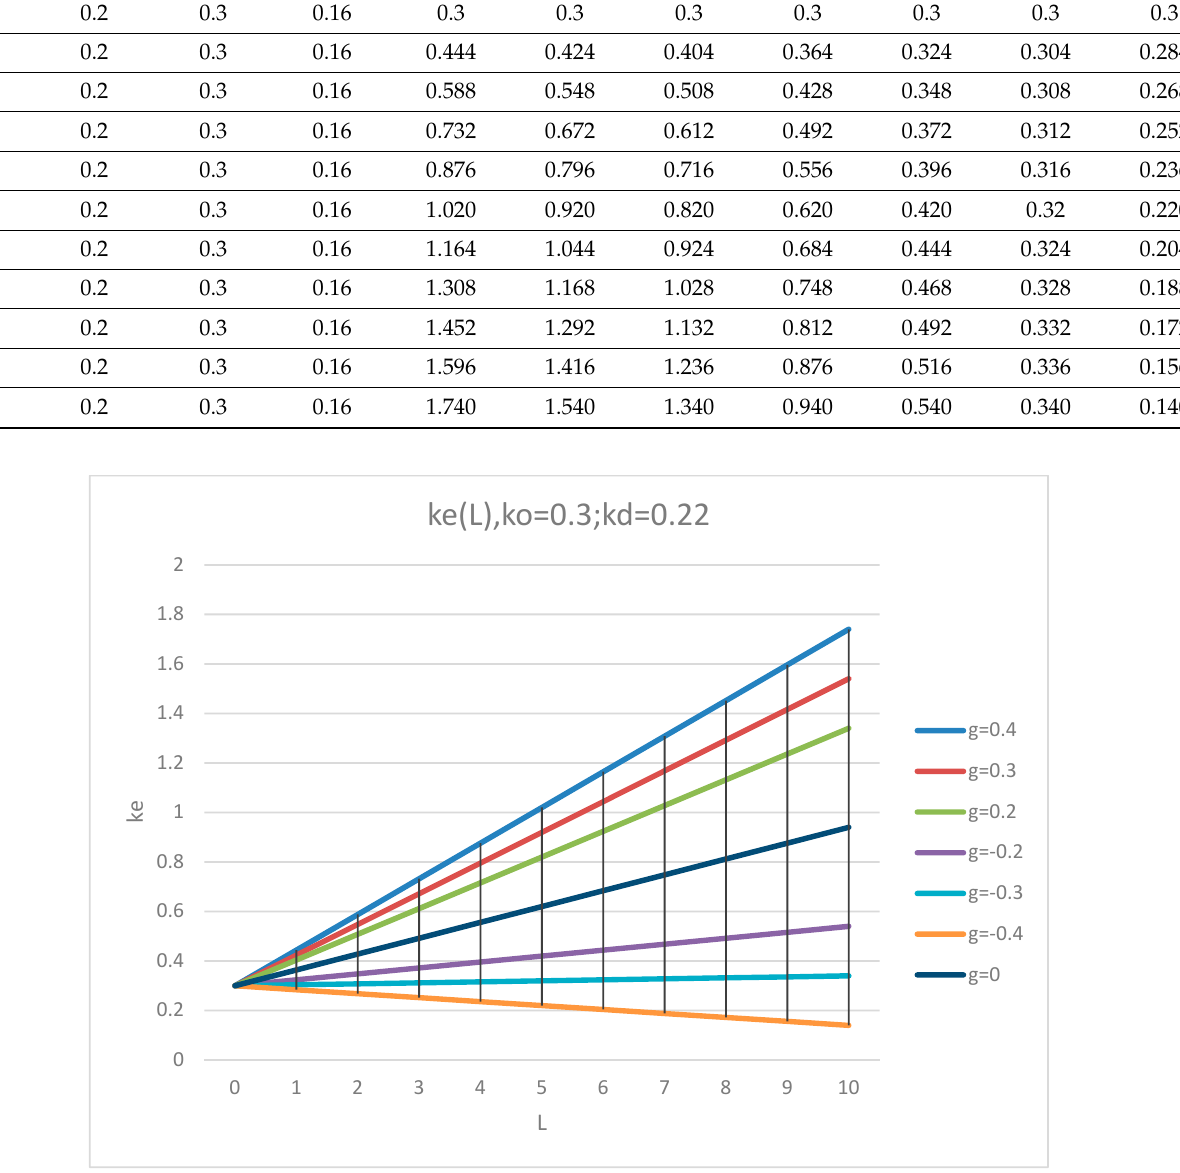
Figure 9. Dependence of equity cost k e on leverage level L in Generalized Modigliani–Miller theory (GMM theory) at k 0 = 0.3; k d = 0.22 and g = 0; ± 0.2; ± 0.3; ± 0.4.